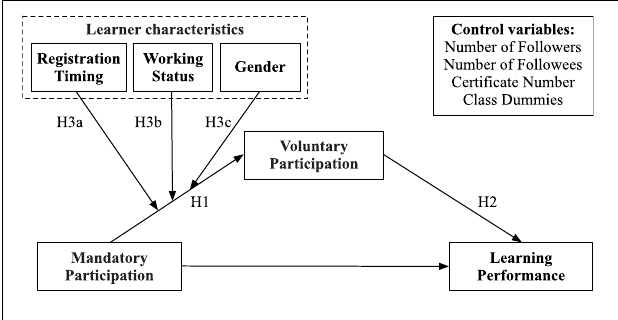
FIGURE 1 | Research